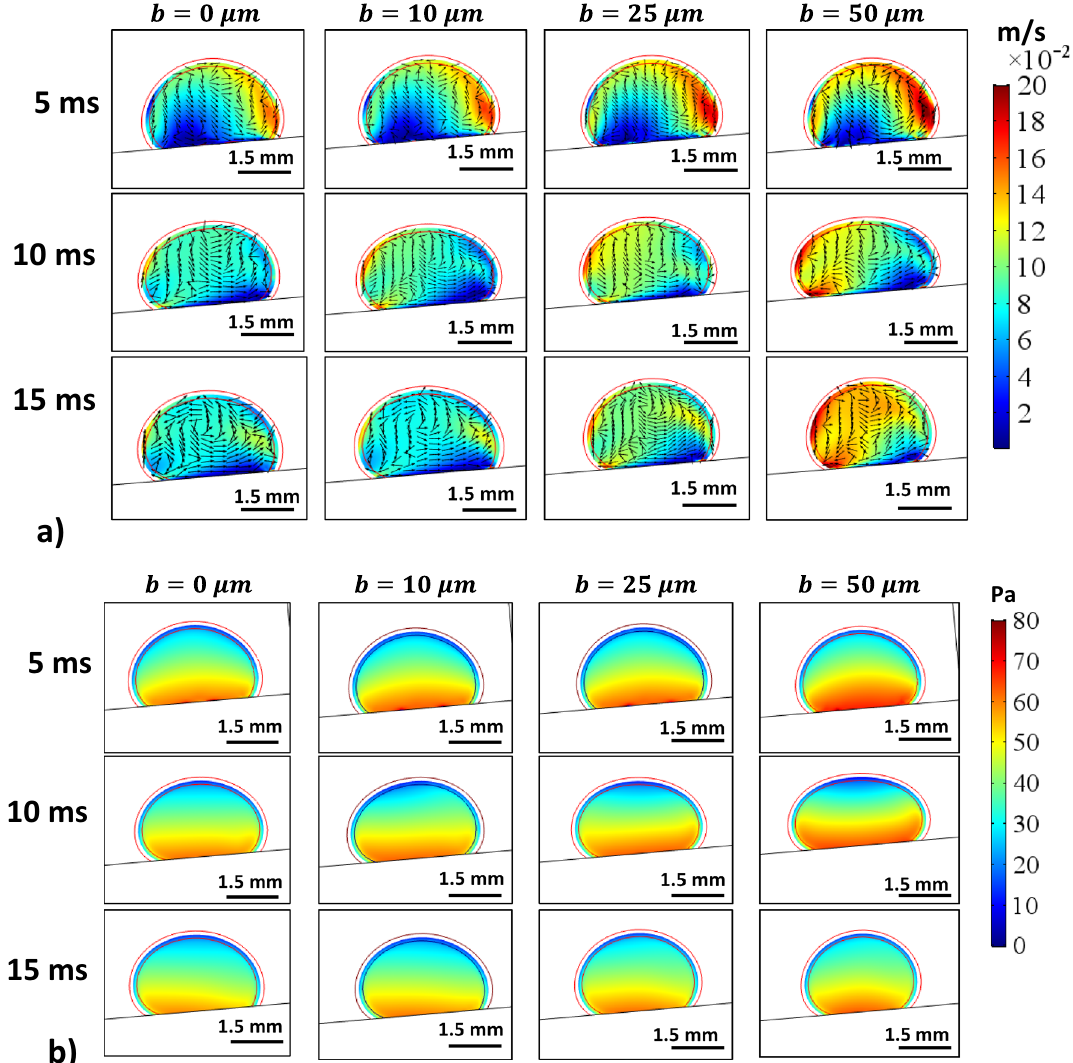
Figure 6. ( a ) Velocity and ( b ) pressure contours in a rolling droplet at different durations for different micro- post spacings. Droplet volume is 40 µL, the inclination angle is δ = 5°. Section cut taken at the cross-sectional plane ( y = 0